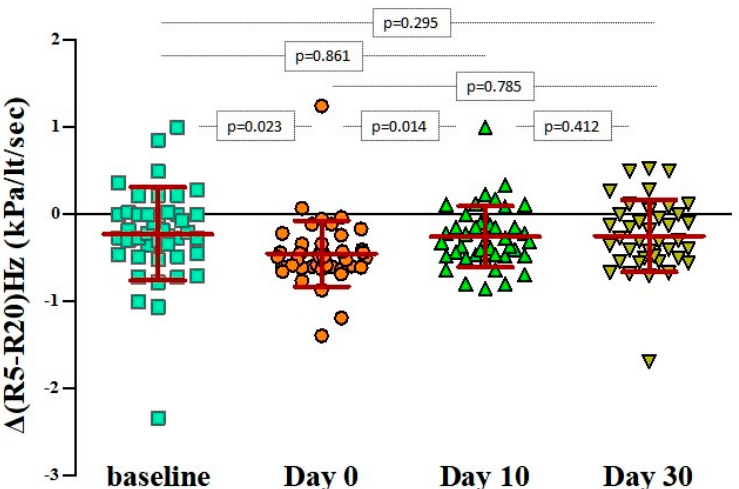
Figure 3. Pairwise comparisons of ∆ (R5Hz − R20Hz) values at baseline, on day 0 (beginning of the wheezing episode), and 10 and 30 days after. The bars and in-between lines represent the mean and SD. All pairwise comparisons are presented with p -values that have been estimated with paired Student’s t-test. Pulmonary resistance (R) at 5 Hz (R5) and 20 Hz (R20); ∆ R(5 − 20)Hz = ((R5Hz − R20Hz) post-bronchodilation − (R5Hz − R20Hz) pre-bronchodilation ) / (R5Hz − R20Hz) pre-bronchodilation.